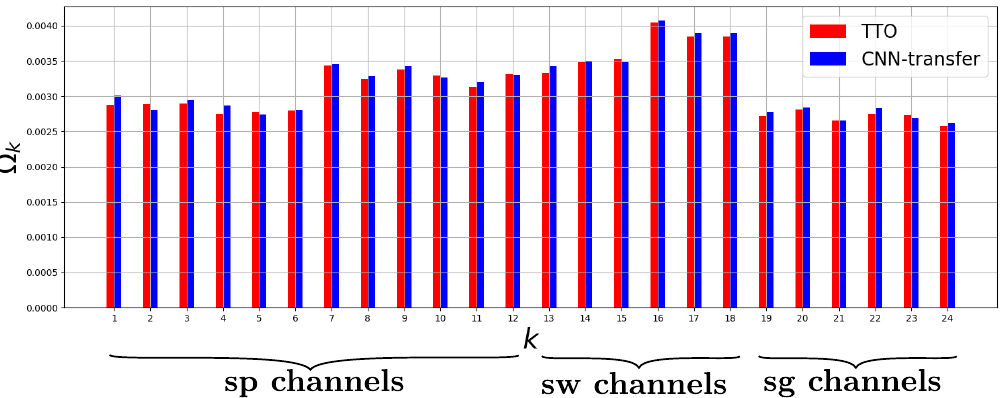
Figure 6. Global channel-wise Jacobian scores Ω k for mDNNs trained by TTO (red) and CNN-transfer (blue). These scores are computed for BBH on the testing set of the CogAge dataset. sp , sw and sg refer to smartphone, smartwatch, and smartglasses,